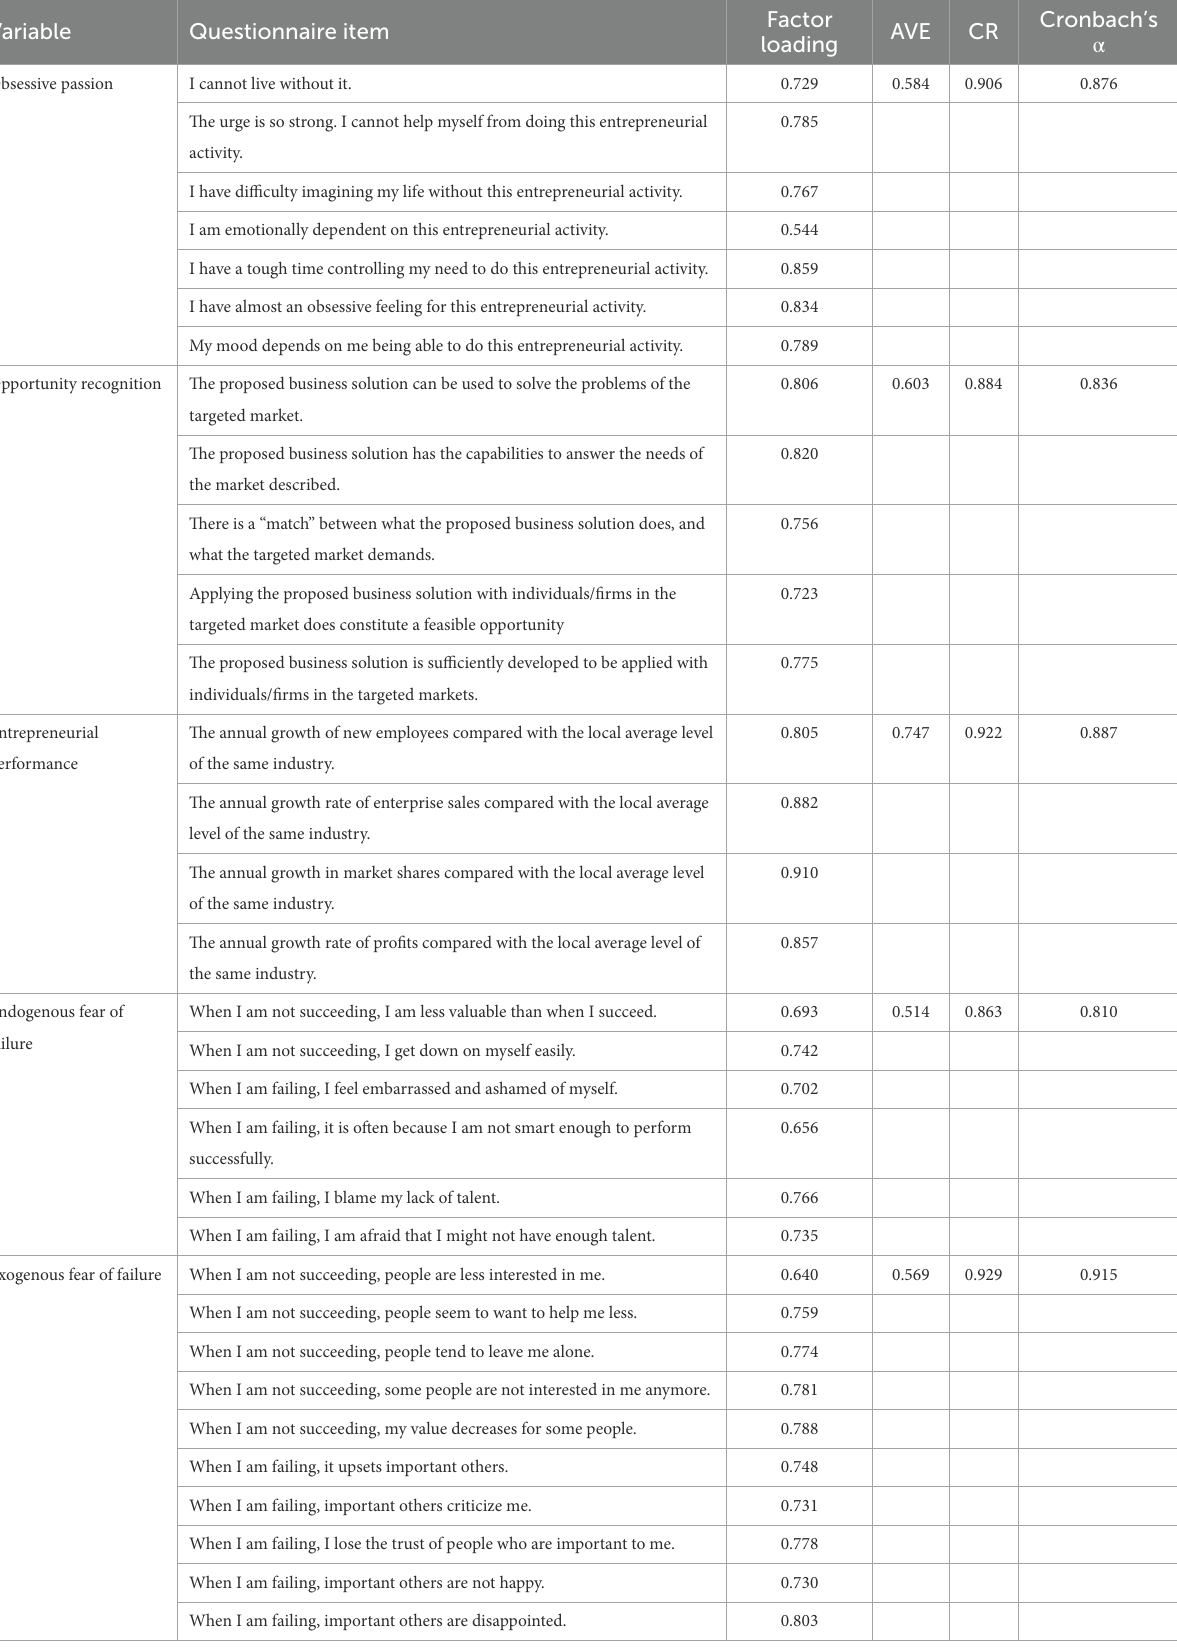
Factor Cronbach’s AVE CR loading α